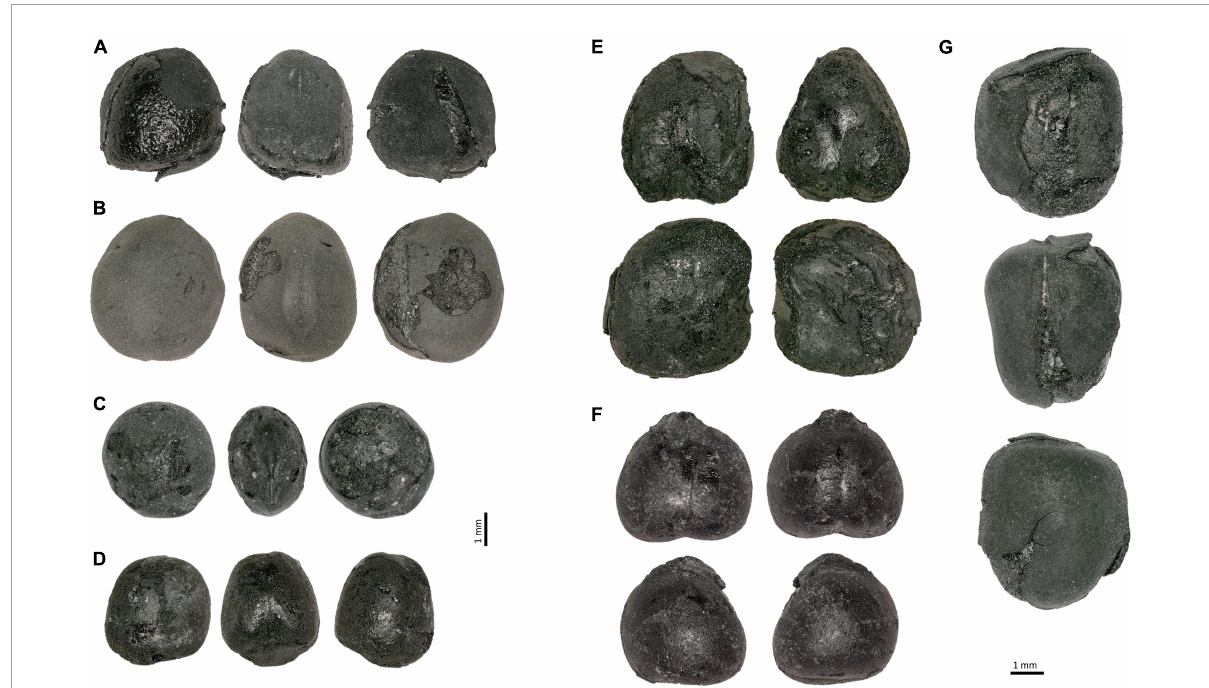
FIGURE5 Selection of pulses/legumes present in the assemblage: (A) Pisum sativum , (B) Vicia cf. sativa , (C) Lens culinaris , (D) cf. V. ervilia , (E) Lathyrus sativus , (F) cf. Cicer arietinum , and (G) V. faba .